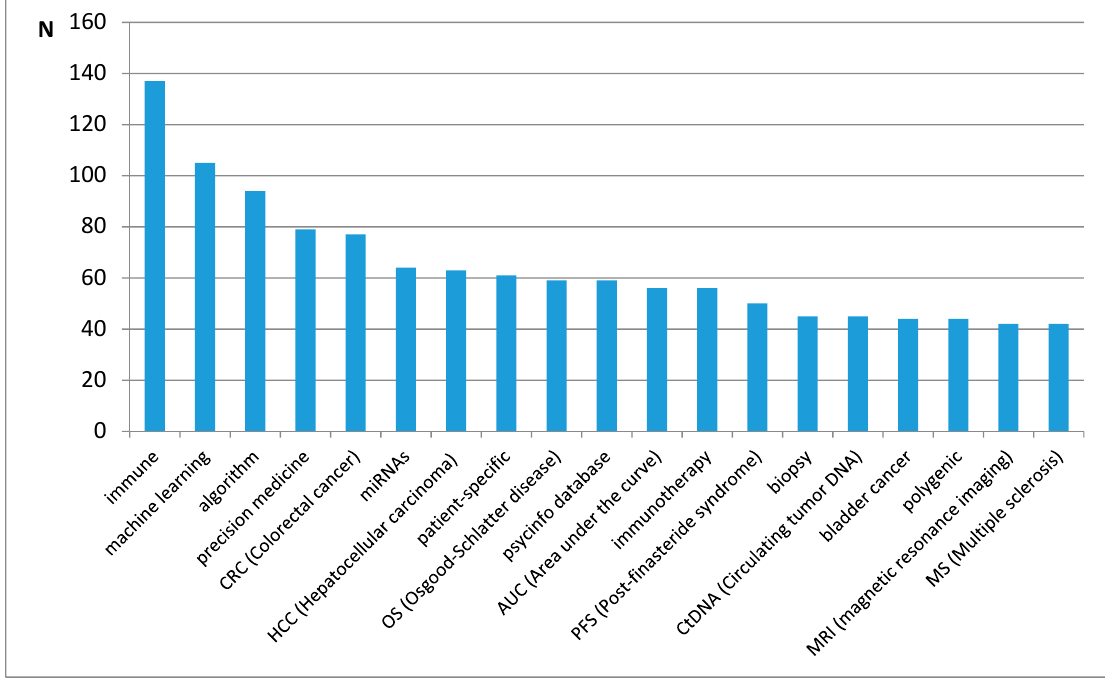
Figure 9. The frequency of occurrence of terms in the vicinity of the derivatives “predict” and “personalis(z)e” over the last years (N is the number of terms).